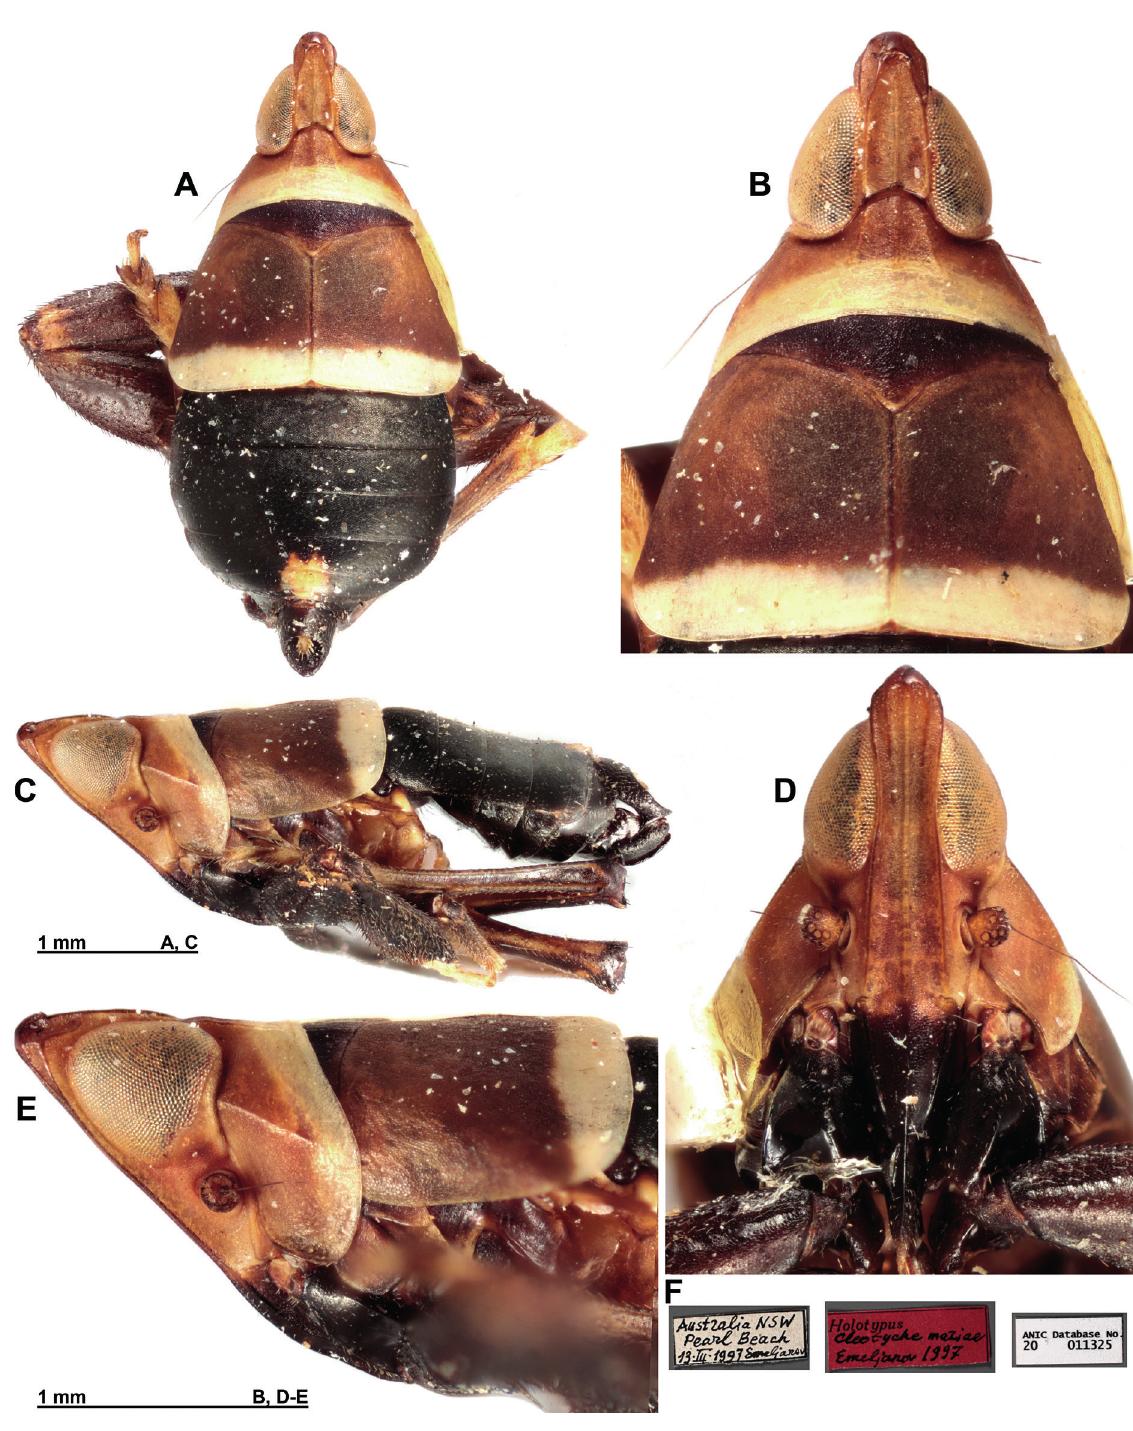
Fig. 11. Cleotyche ( Cleotyche ) mariae Emeljanov, 1997, ♂, holotype (ANIC). A . Habitus dorsal view. B . Head and thorax, dorsal view. C . Habitus, lateral view. D . Frons, perpendicular view. E . Head and thorax, lateral view. F . Labels. Photographs: © T. Pleines –